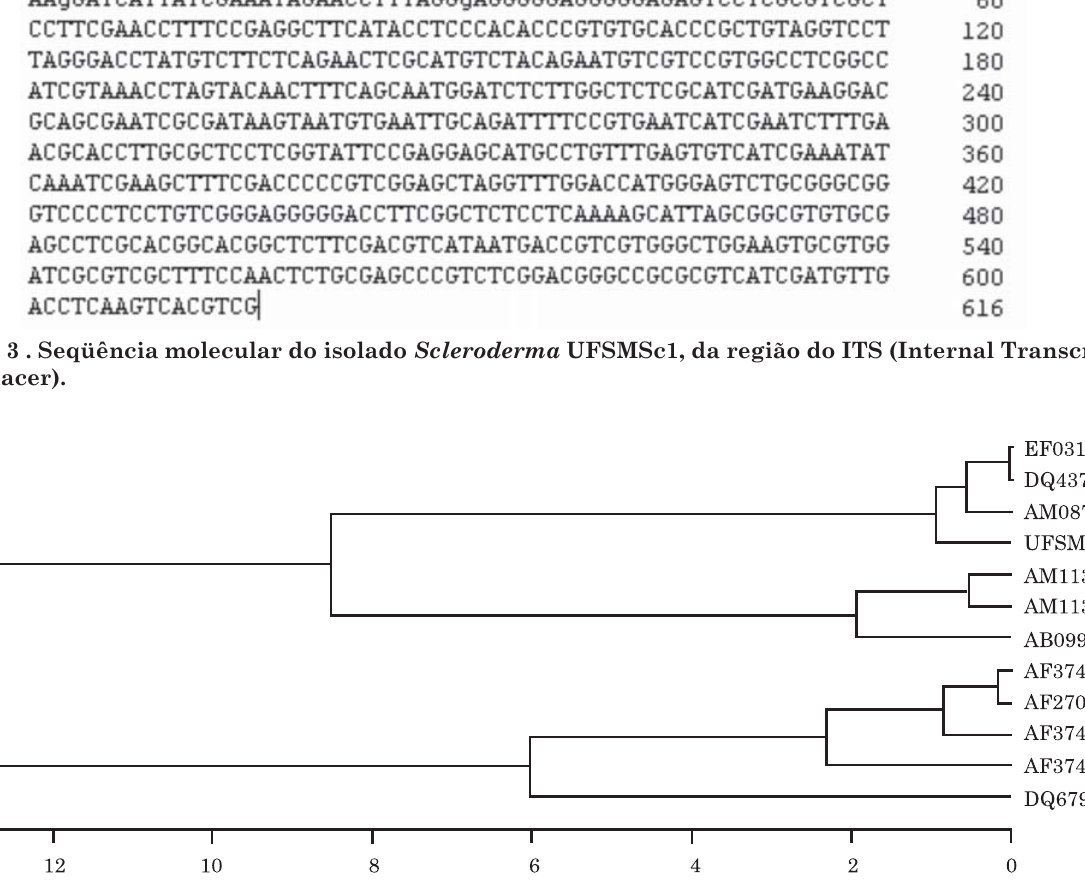
Figura 4. Dendograma das distâncias nucleotídicas entre Scleroderma UFSMSc1 e isolados de Scleroderma e Pisolithus de seqüências depositadas no GenBank (Numero de acesso), construida pelo método UPGMA. Fungos não cultivados (AM087282, EF031135, DQ437705, AM113465, AM113464), Scleroderma sp (AB099900) Pisolithus tinctorius (AF374694, AF374713, DQ679804, AF374639), Pisolithus sp